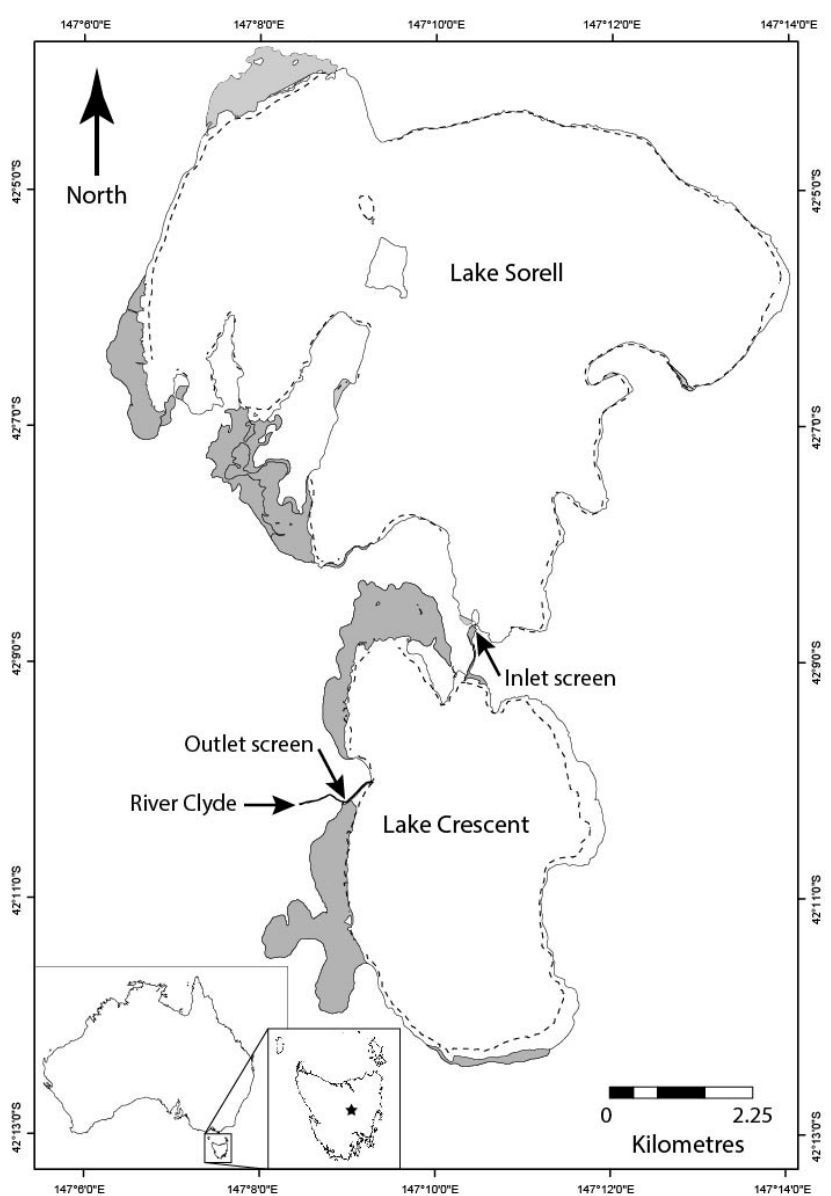
Figure 1. Map of lakes Sorell and Crescent showing the location of the River Clyde, containment screens, wetland areas (shaded grey), and the level of wetland inundation (dotted lines). The integrated management activities contained the carp to these two lakes with eradication achieved in the latter (Adopted from Taylor et al. (2012) [27]). Inset are maps of Australia and Tasmania, with the location of the lakes (star) (Left hand side, bottom).